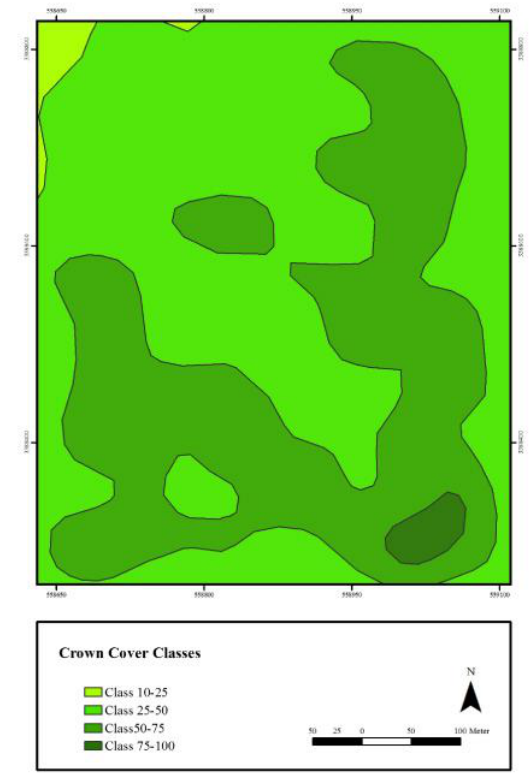
Figure 8. Canopy density map with 30 Ar cell